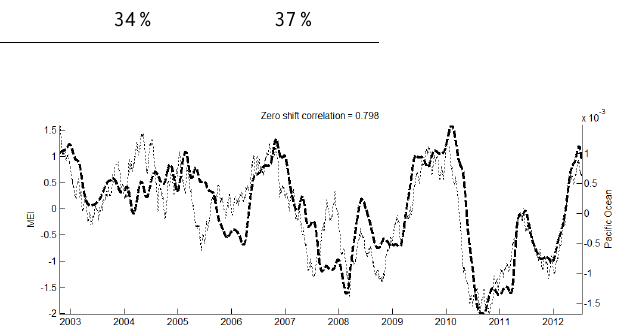
Figure 8. The DCCw0 anomaly for averaged day/night over the Pacific Ocean and the MEI (heavy 691 Fig. 8. The DCCw0 anomaly for averaged day/night over Pacific trace), smoothed with a 96-day running average. 692 Ocean and the MEI (heavy trace).